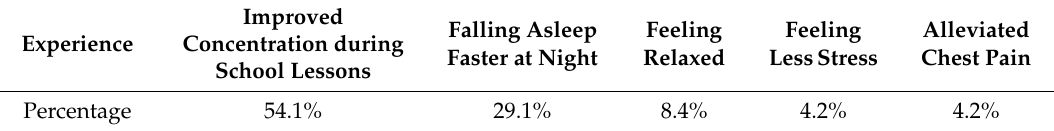
Table 4. Experiences and statistics from training